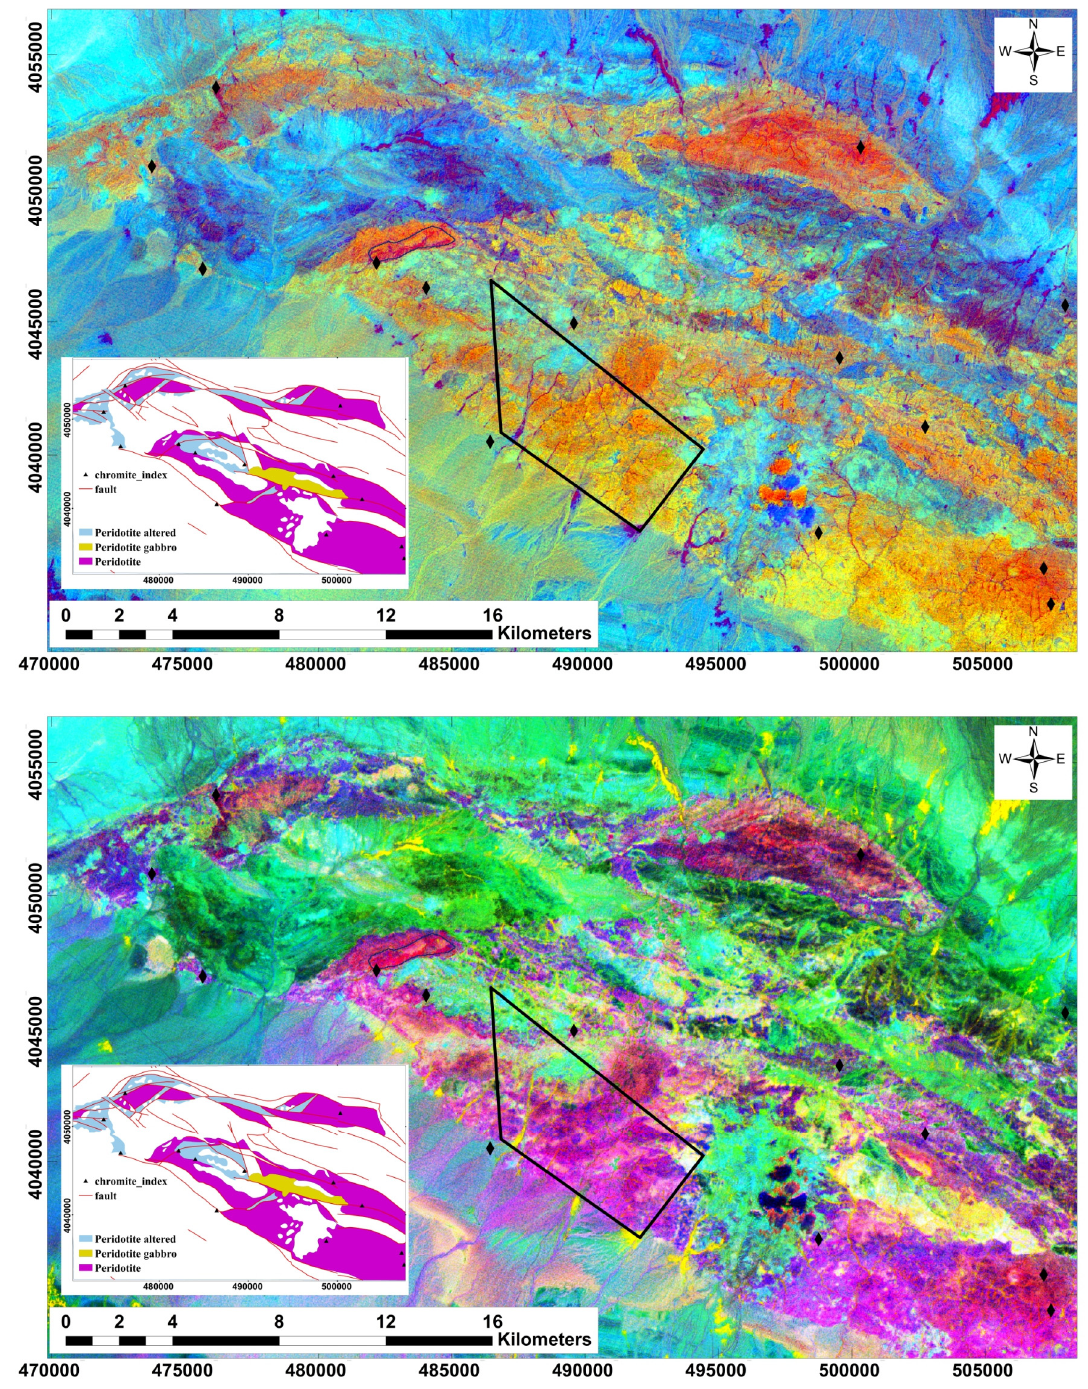
Figure 6. The band ratio (7 + 9)/8, 4/3, 5 with linear enhanced ( upper image) showing serpentinized peridotite as orange to yellowish-orange color. The band ratio (4/6 4/3, 2/3 × 4/3) shows highly serpentinized ultramafics as purple colors. The enhanced colors display a correlation with the location of chromite indexes shown with black diamonds. The black rectangle is the main surveying area, and the blue polygon is the boundary of open-pits of the chromite mine. The inset map shows the distribution map of peridotites and serpentinized peridotites extracted from the regional geology map. The general pattern of the two maps shares similarities.